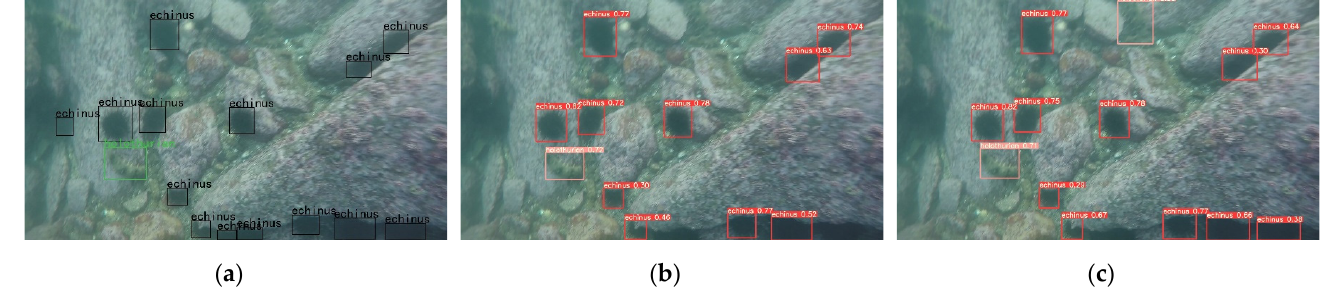
Figure 19. The comparison of detection results of some images in test set: ( a ) ground truth; ( b ) detection results of the baseline model trained without non-overlapping fi lling; and ( c ) detection results of the baseline model trained with non-overlapping fi lling.